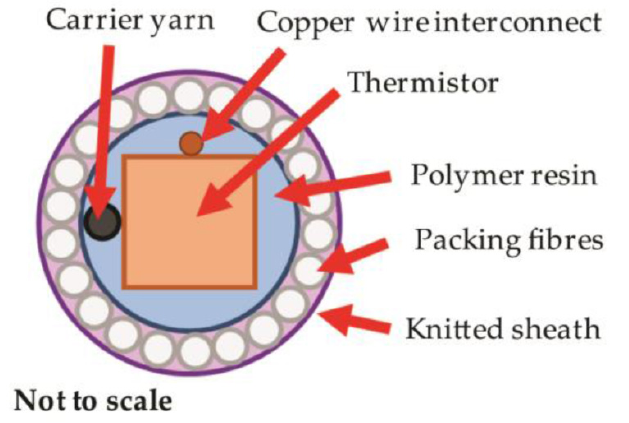
Figure 6. Cross-sectional scheme of thermistor encapsulated in a yarn comprising polymer resin, packing fibers and knitted sheath. The carrier yarn within the resin encapsulation improves the tensile strength of the final yarn. From Reference [105], originally published under a CC-BY license.